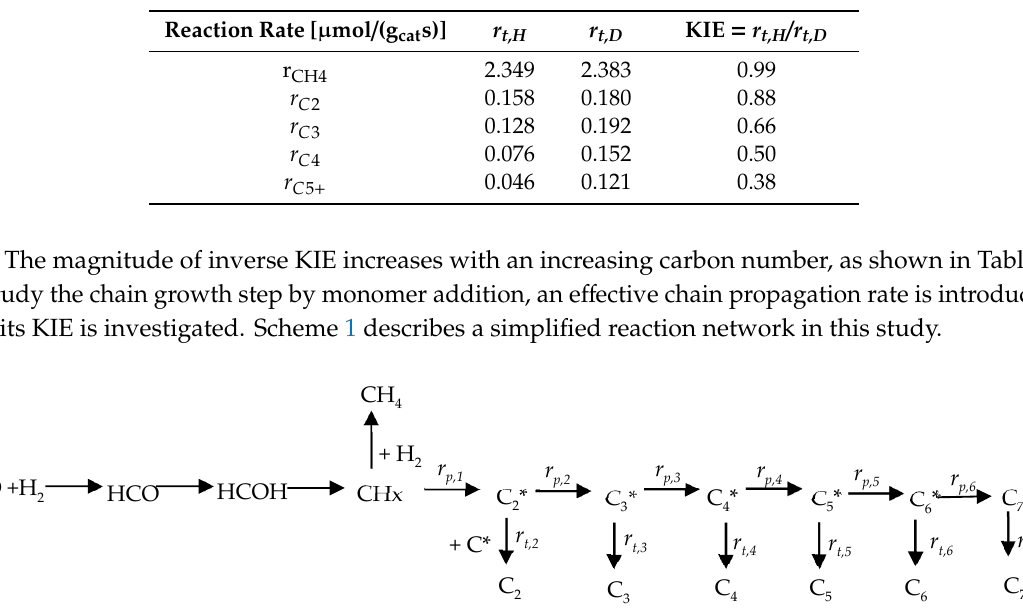
Scheme 1. Reaction network of cobalt-catalyzed Fischer-Tropsch synthesis.